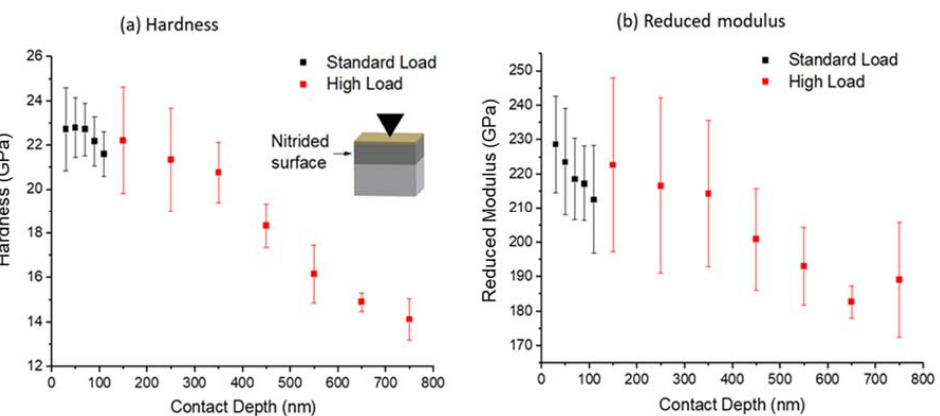
Figure 6. Surface indentation obtained ( a ) hardness and ( b ) reduced modulus as a function of depth in nitrided Zircaloy-4 (nitrided at 800 °C for 24 h). The indentation was applied along the normal direction of the nitrided surface.